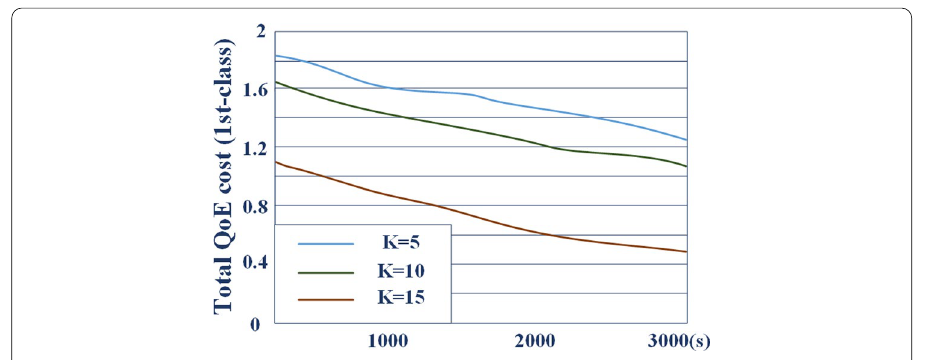
Fig. 13 QoE (c1) under different flow amount